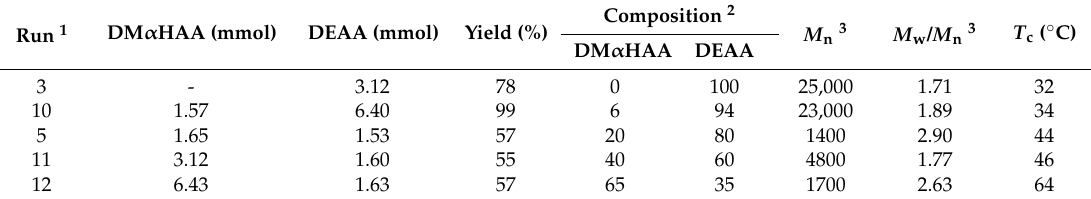
Figure 3. Photographs of poly(DM α HAA- co -DEAA), obtained in Run 5, in water (1 wt %): ( a ) at 50 °C, ( b ) at 44 °C, and ( c ) at 25 °C; ( d ) Plots of content of DM α HAA unit versus T c . Table 2. Radical (co)polymerizations of DM α HAA with DEAA and the cloud points of the resulting